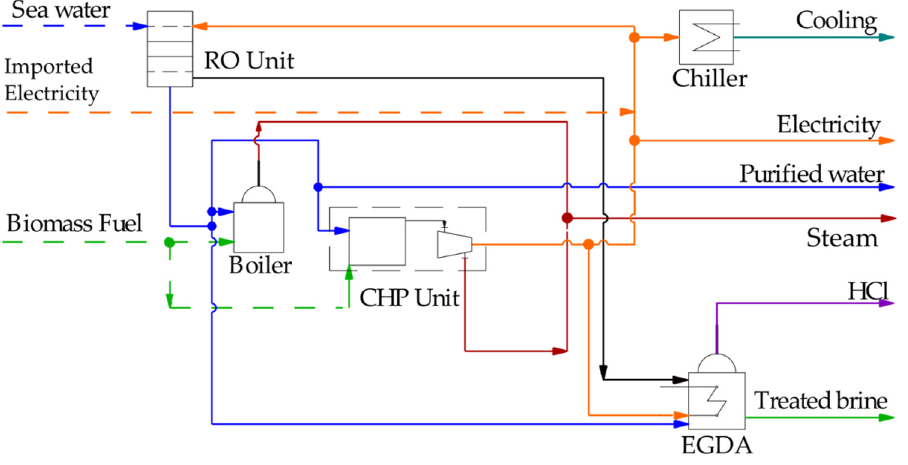
Figure 2. Structural representation of the synthesis problem.